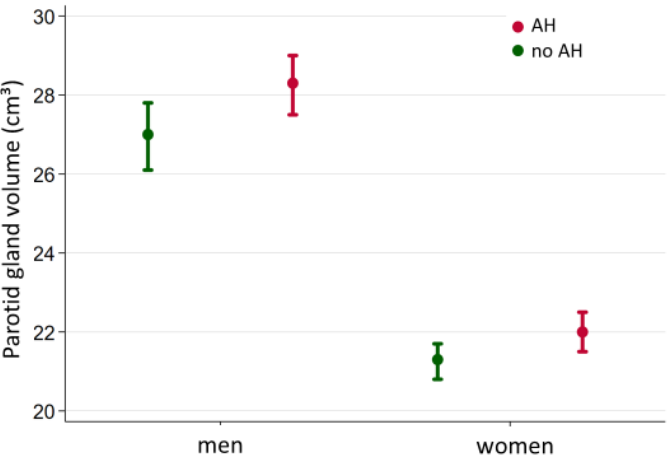
Figure 7. Volume differences in the presence of arterial hypertension differentiated by gender. Overall, more significant associations were observed for the entire cohort than for either the male or female subgroups. In females, BMI, waist circumference, serum triglyc-